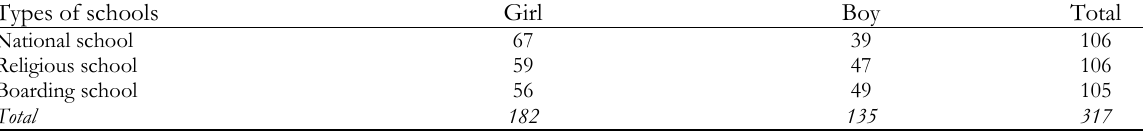
Table 1. Number of samples for national school, religious school and boarding school Types of